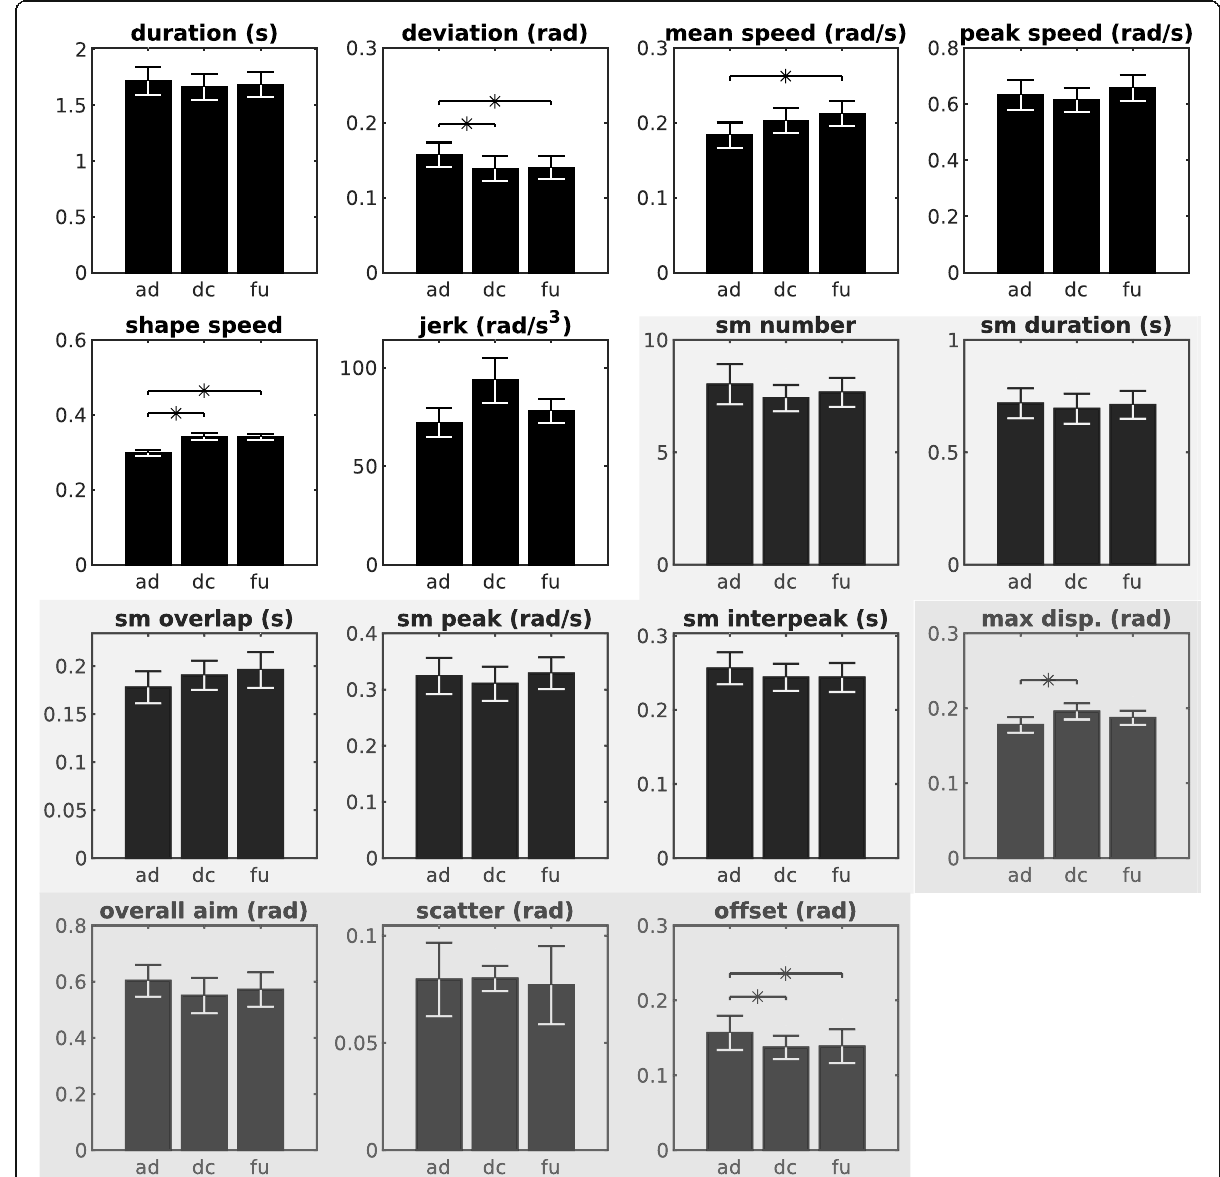
Fig. 3 Combined Robot tDCS and Robot Sham mean and standard error of kinematic and kinetic outcome metrics for the wrist. Significant changes ( P < .0167) between admission (ad), discharge (dc), and follow-up (fu.) are marked with an * Note: The bar-graphs in white background represent the unconstrained trained pointing macro-metrics, the lightest grey shading background represents the unconstrained trained pointing micro- metrics (sm= sub-movement), and the darkest grey represents the reaching against resistance, isometric stabilization, and kinetic metrics (respectively, see Additional file 1 for further details on the